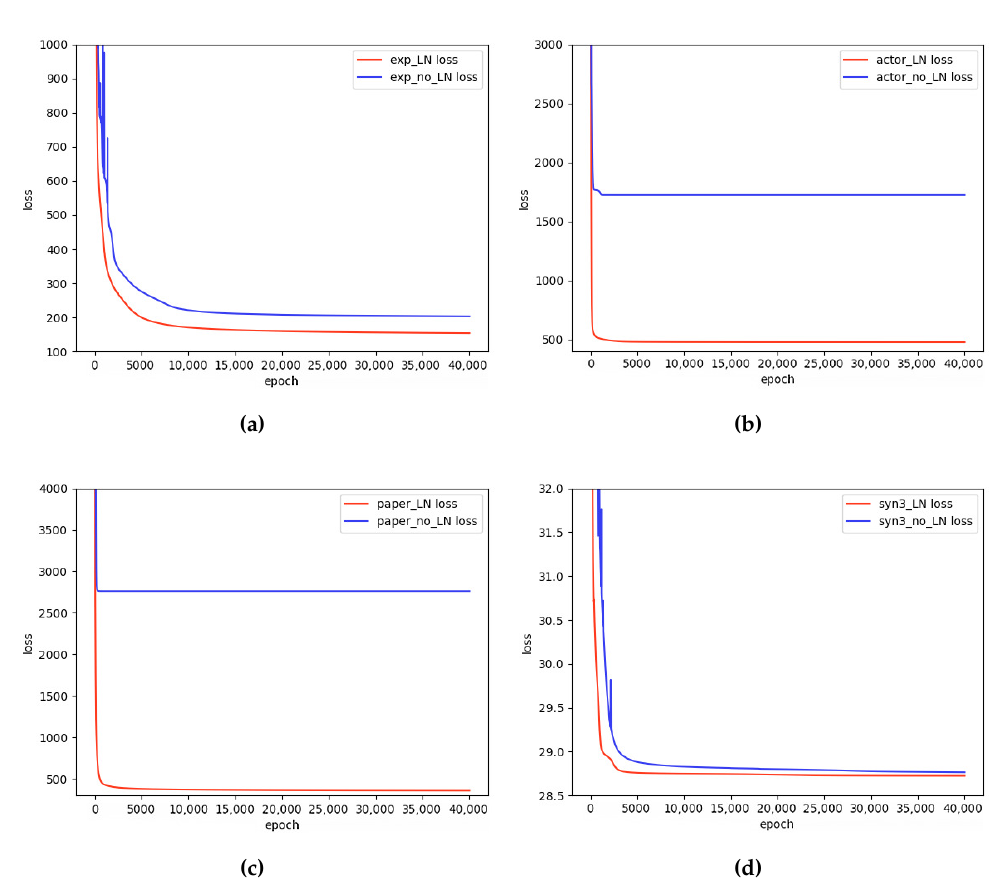
Figure 5. Decline curve corresponding to whether to add layer normalization layers (LN) in the proposed network architecture with reprojection loss and temporal constraint in expressions, actor mocap, paper, and syn3. ( a ) expressions; ( b ) actor mocap; ( c ) paper; ( d )